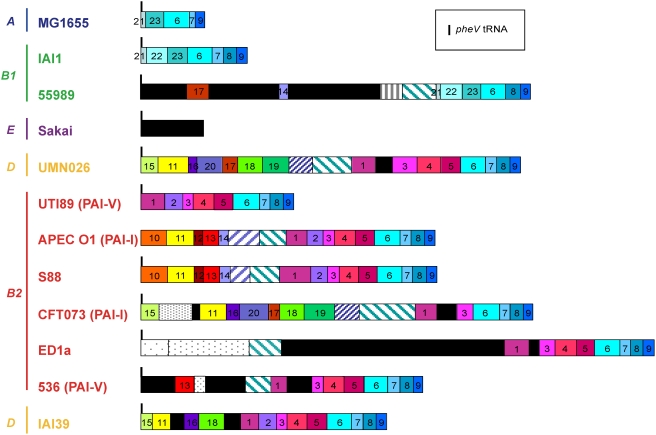
The genomic island at the pheV tRNA insertion hot spot in the different Escherichia coli strains.The figure provides a synthetic view of the pheV tRNA insertion hotspot in the different studied E. coli strains. This region has been defined using the synteny breaks among 12 E. coli strains. In E. coli K-12 MG1655, the genes immediately flanking the pheV tRNA gene are the ECK2960 gene (speC, ornithine decarboxylase) and the ECK2981 gene (pitB, phosphate transporter). In strain APEC O1, the pheV tRNA gene is absent. As most E. coli genomic regions have a composite structure, e.g., a region partially conserved or found in different synteny groups in other strains (i.e., at different genomic locations), we have manually divided this large genomic island into sub-regions (or modules), which are found in only a subset of the compared E. coli strains. Homologous modules have the same colour code and identifying number throughout. A total of 23 homologous modules were defined. The composition of these modules (i.e, the lists and functional descriptions of the constituent genes) is available in Supplementary Table 7. Black modules are strain-specific. Modules with hatched patterns correspond to repeated regions. Modules with grey dotted patterns are found in other strains but at another genomic location. The pathogenicity island published as PAI-V in UTI89 and 536 or PAI-I in APEC O1 and CFT073 ends just before module number 6.